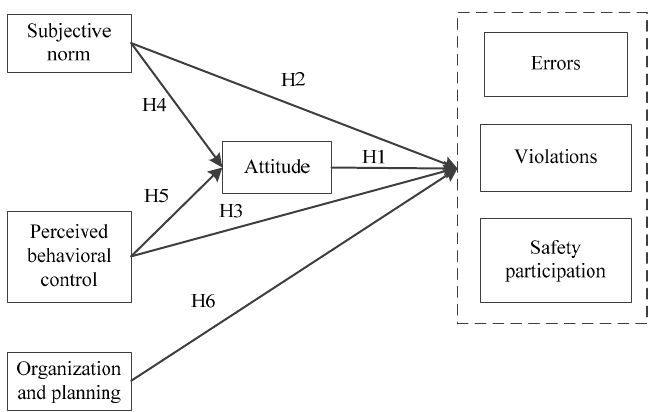
Figure 1. Proposed model for explaining errors, violations, and safety participation behavior of commissioning workers.